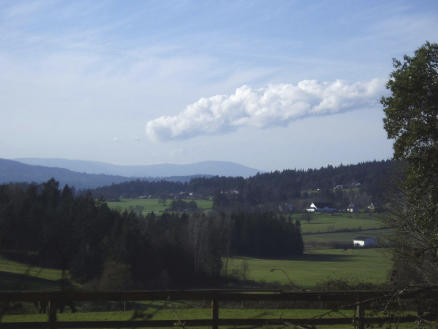
Pristine Parts of the ValleySome of the valley still constitutes pristine environment, which is mostly used for farming.